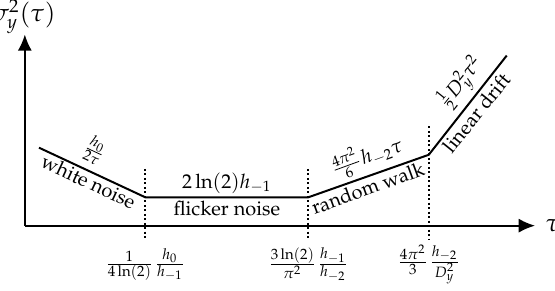
Figure 7. Schematic progression of the Allan variance σ 2 y ( τ ) as a function of the measurement time τ for various noise processes and linear